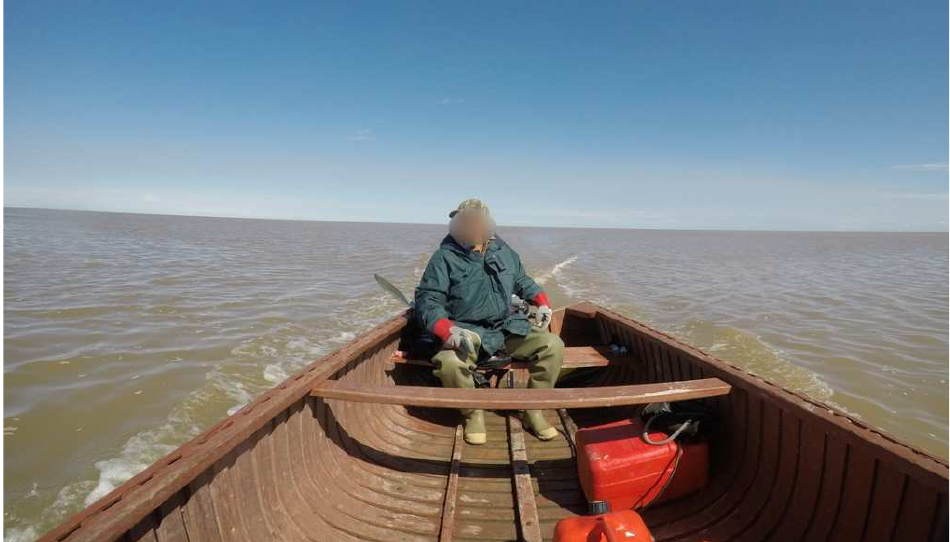
Figure 2. An Elder on a canoe guiding youth and other participants during the goose harvest.